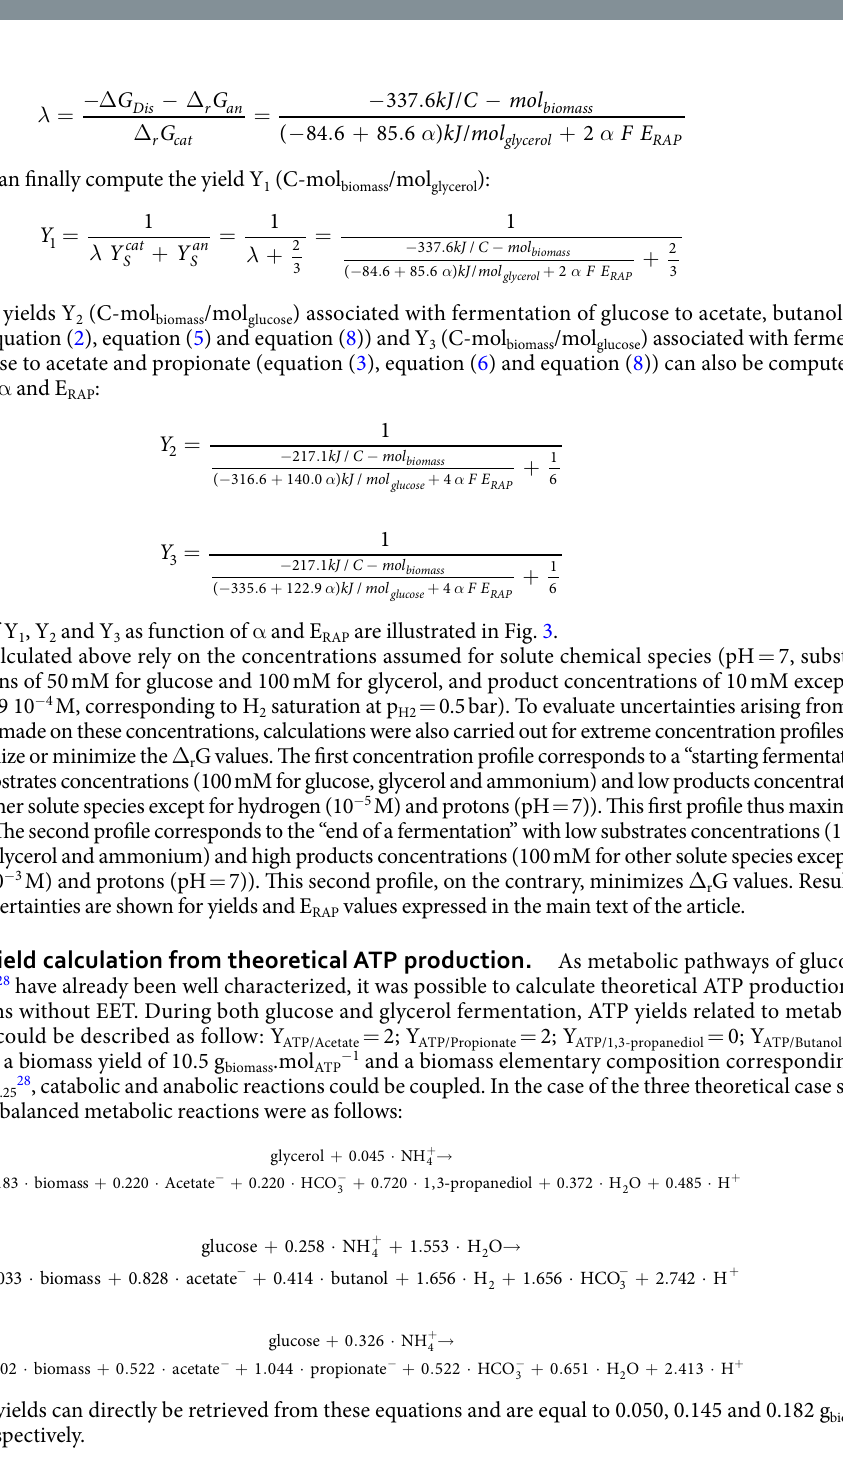
Data retrieval from the literature and thermodynamical model fitting. The three case studies con- sidered in the present article corresponded to two electro-fermentation experiments 8, 13 and one co-culture of a fermentative microorganism with an EAB 18 . In these studies, complete characterization of metabolic products and bacterial biomass production were provided. For Emde and Schink 8 , the raw data corresponded to the results from their Table 2 for the conditions “None” ( i.e . fermentation) and “CoS (40)” ( i.e . fermentation + EET). In the case of Choi et al . 13 , data were retrieved from their Supplementary Table 2 providing electron and carbon mass balances for fermentation and fermentation + EET (referred as “control” and “BES”, respectively). Finally, data from Moscoviz et al . 18 were extracted from Fig. 3 showing electron and carbon mass balances for pure culture of C. pasteurianum (fermentation) and co-culture of C. pasteurianum with G. sulfurreducens (fermentation + EET). Although mass balances from these datasets closed at nearly 100%, the raw stoichiometric balances were corrected using HCO 3 − and H 2 as adjustment variables to obtain a carbon and electron recovery of 100%. The stoichiometric calculations are provided as Supplementary materials and the resulting corrected carbon mass balances are displayed in Fig.